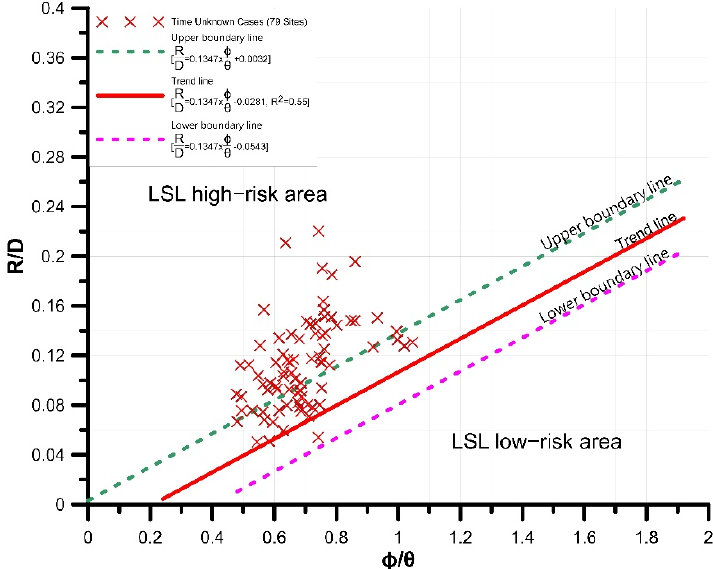
Figure 5. Dimensionless factor relationship of LSL cases with unknown occurrence time.